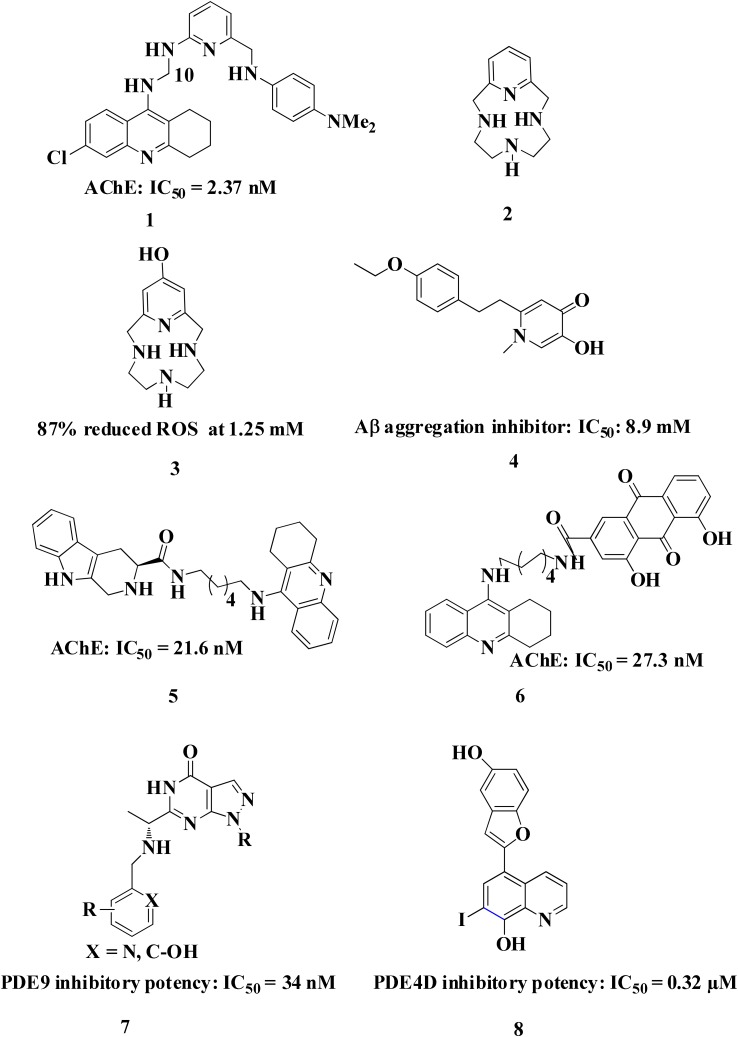
Structures of MTDL.